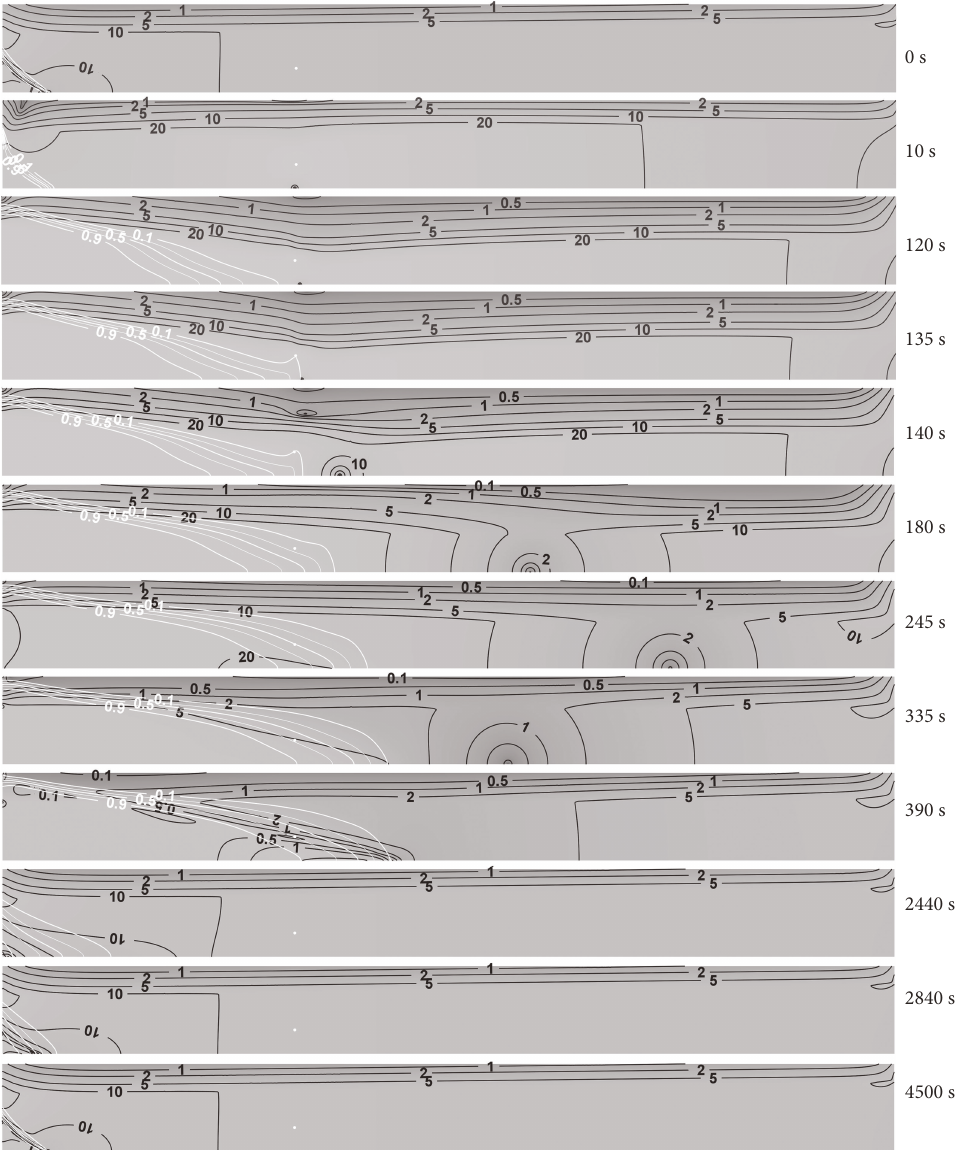
Figure 6: Selected time frames of the numerical simulation from t = 0 s to t = 4500s . White lines are relative concentration contours of 0.1, 0.3, 0.5, 0.7, and 0.9, and black lines are Darcy fl ow velocity contours of 0.1, 0.5, 1, 2, 5, 10, and 20 m/s. The small white dot shows the well location at x = 0 6 m and y = 0 05m in every